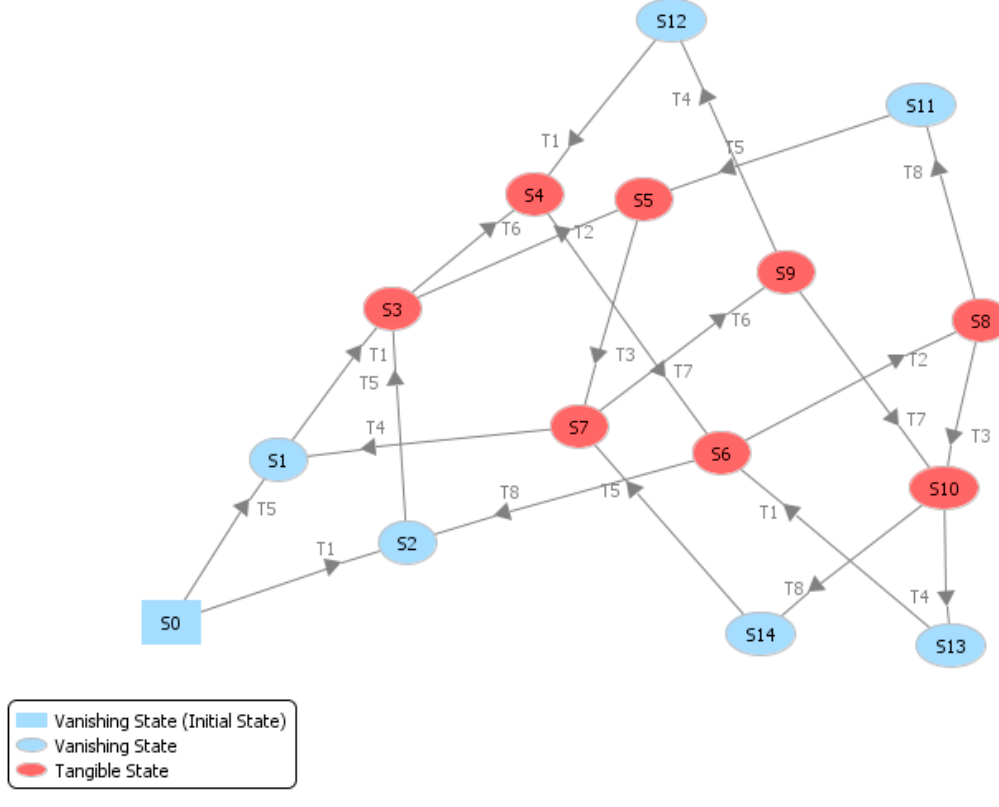
Figure 20. Case IV: reachability/coverability graph obtained by the PIPE simulator for the first proposed solution.